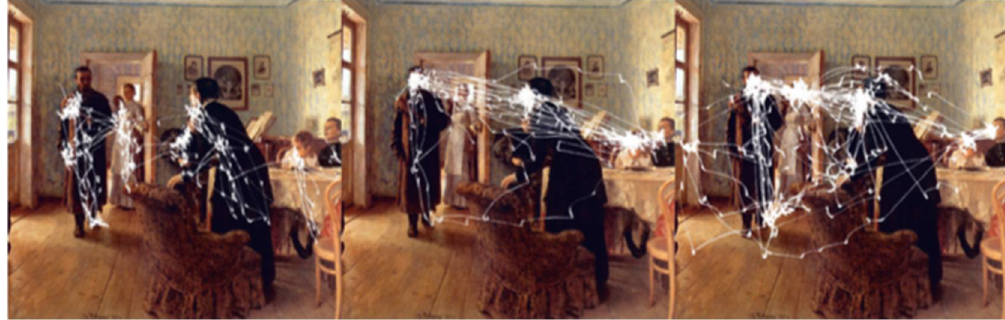
Figure 4. Reproduction from I.E. Repin’s picture “An Unexpected Visitor” and records of the eye movements of seven different subjects. Image from Eye Movements and Vision by Alfred Yanus [7]